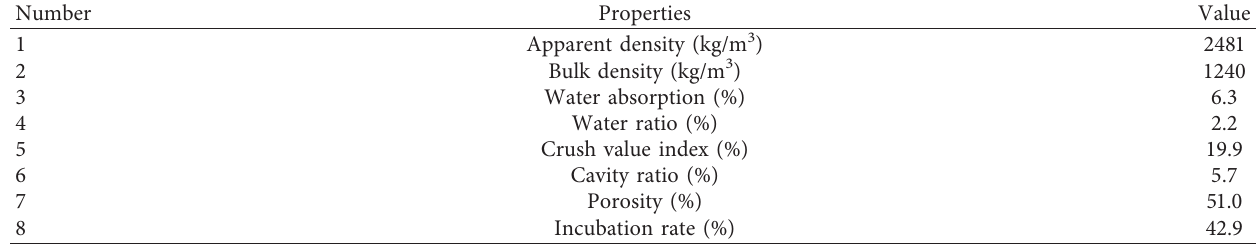
Table 3: Main properties of recycled coarse aggregate.